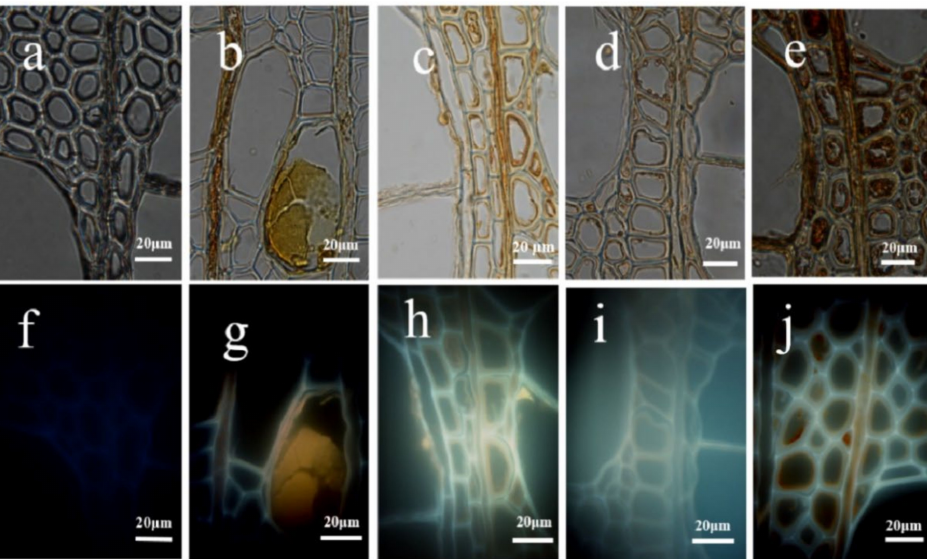
Figure 4. Optical and fluorescence photos of the poplar cross section under different treatment conditions. ( a – e ) are optical images, and ( f , j ) are fluorescent images ; ( a,f ) for the unmodified treatment group, ( b , g , c , h , d , i ) for the 110,100 mmol/L TEOS modification treatment group and ( e , j ) for the SiO 2 colloidal modification treatment